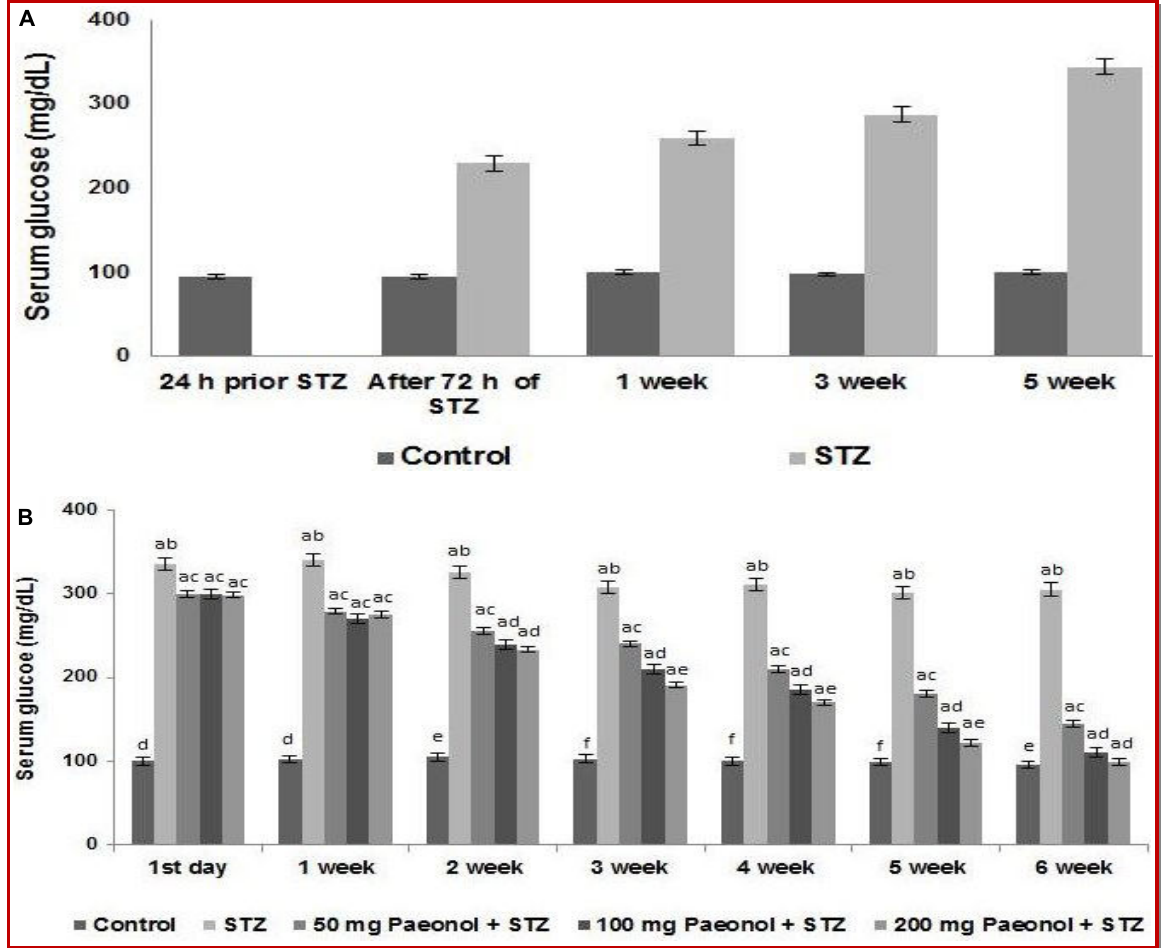
Figure 1: Effect of paeonol on serum glucose levels following streptozotocin induction Values are represented as mean ± SD, n=6. a represents statistical significance at p<0.05 compared against respective controls and b-f represents significant difference (p<0.05) between mean values within the groups as determined by one-way ANOVA followed by DMRT